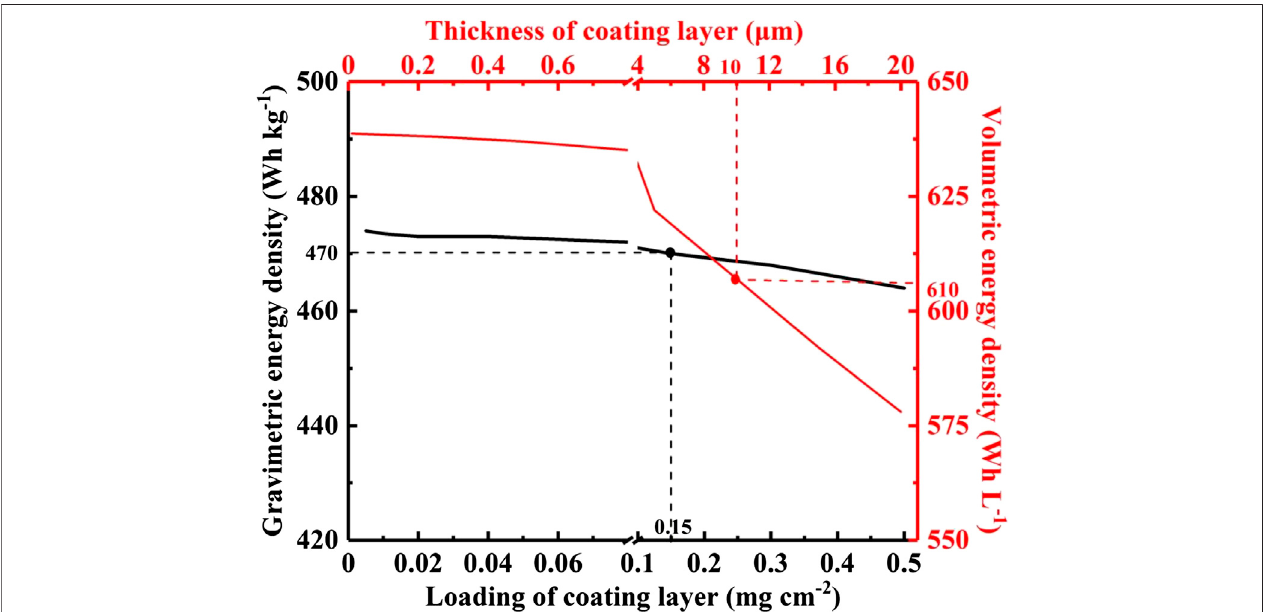
FIGURE 10 | The in fl uence of the coating mass and thickness of functional separators on the energy density of LSBs.